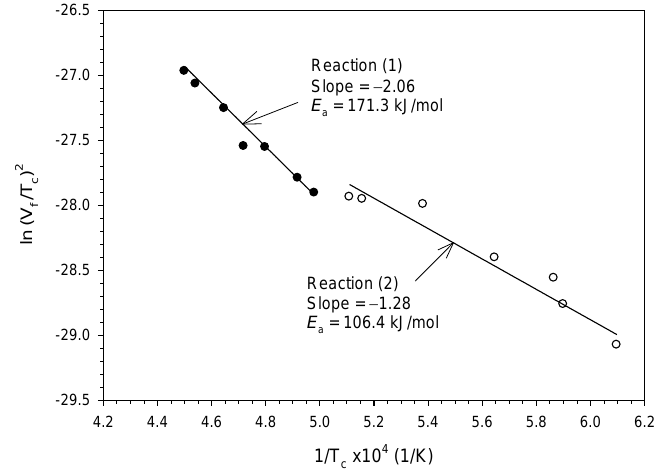
Figure 3. Activation energies ( E a ) of Reactions (1) and (2) deduced from the correlation of combus- tion wave velocity ( V f ) with reaction temperature ( T c ).